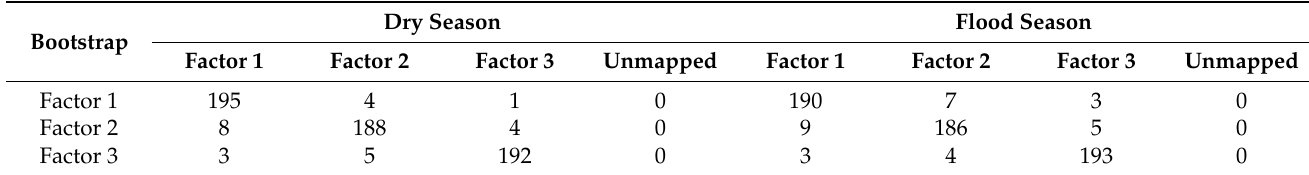
Table 6. Mapping of bootstrap factors to base factors derived from PMF model.